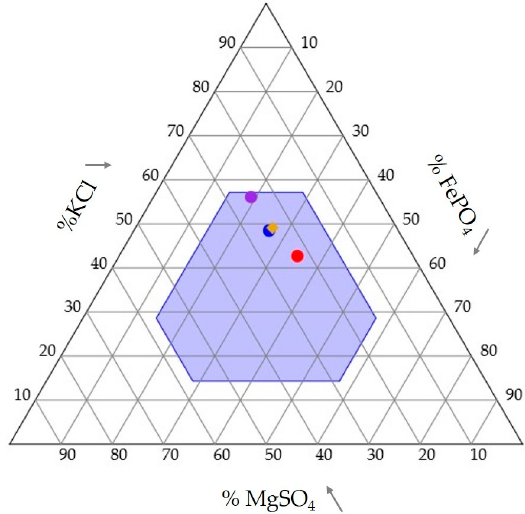
Figure 5. Equilateral mixture triangle summarizing the intake of KCl, MgSO 4 , and FePO 4 for all three trials. The blue, red, and purple dots represent the average intake of the same seven colonies from the Kfe/kFE, MGfe/mgFE, and Kmg/kMG trials, respectively. The light blue area is the area of possible accessibility from the combined trials. The gold diamond is the estimated intake target based on the results for all 7 colonies.